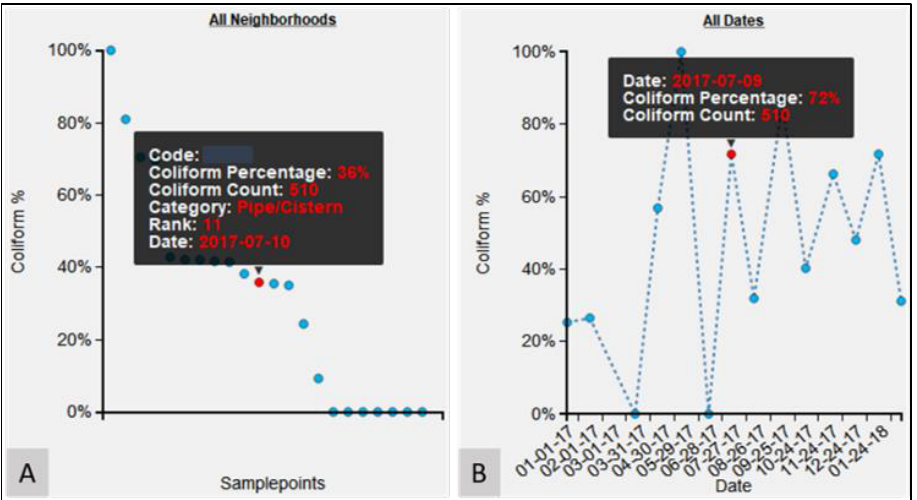
Figure 5. Visualization charts for epidemiological variables. ( A ) Rank-chart for all neighborhoods; ( B ) Time-chart showing longitudinal variation for the particular epidemiological data.